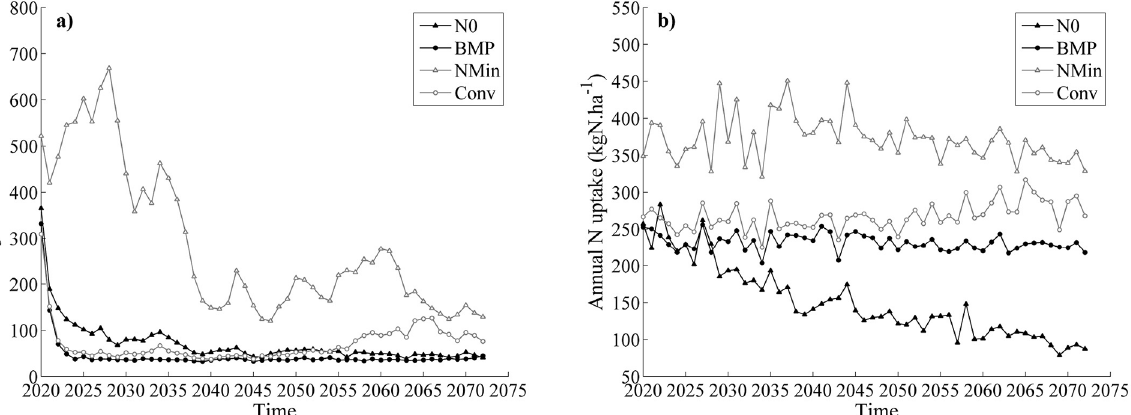
Fig 5. Simulated annual soil nitrate content and maize nitrogen uptake. Simulated median soil nitrate content (a) and annual median nitrogen uptake by the maize crop (b) for the NMIN (grey empty triangle line), CONV (grey empty circle line), N0 (black full triangle line) and BMP (black full circle line) treatments in the long term rotation (2020 –